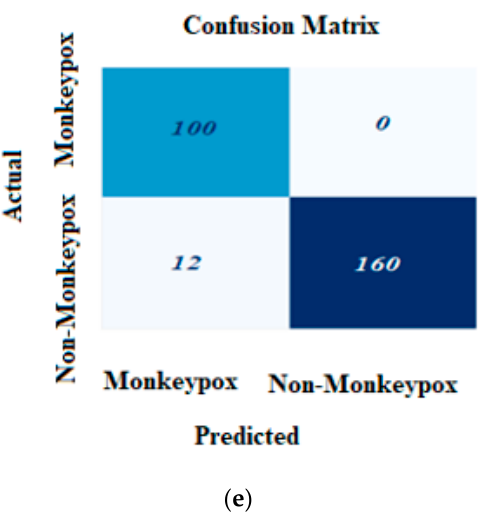
Figure 6. Confusion matrix for our model: ( a ) EfficientNetB3; ( b ) ResNet50; ( c ) VGG16; ( d ) Mo- bileNetV2; ( e ) VGG19.